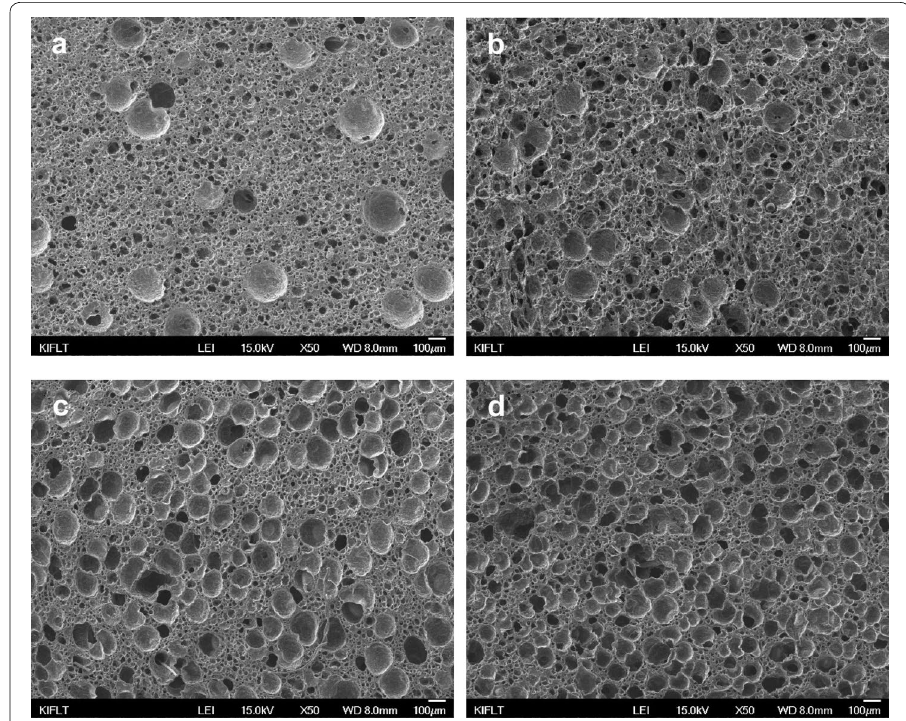
Fig. 4 SEM images of bio‑EPDM foam with TBNRs (x50); ( a ) T‑0, ( b ) T‑1, ( c ) T‑2, ( d )